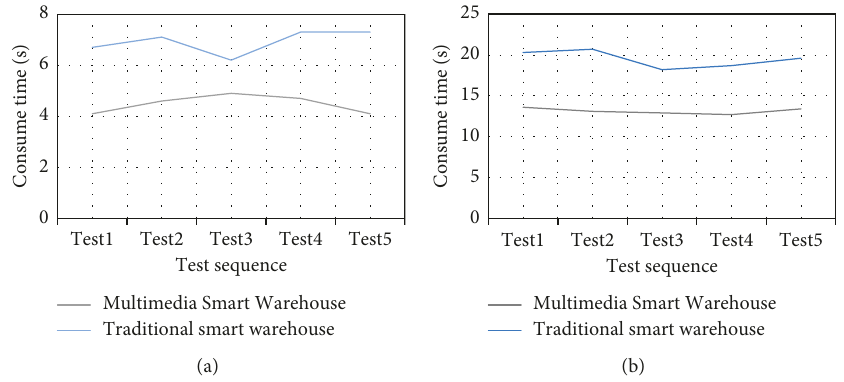
Figure 8: Intelligent warehousing inquiry and sorting of goods time. (a) shows the time it takes for each warehousing system to inquire about goods. (b) shows the time it takes for each warehousing system to sort out the